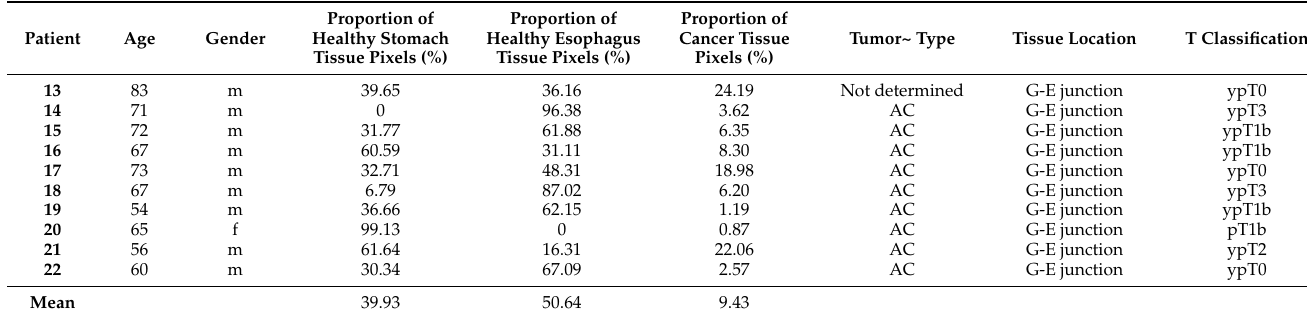
Table 2. Summary of the esophagogastric dataset. There is one hypercube per patient. AC, SC and G-E stand for adenoma carcinoma, squamous cell carcinoma and gestro-esophageal,